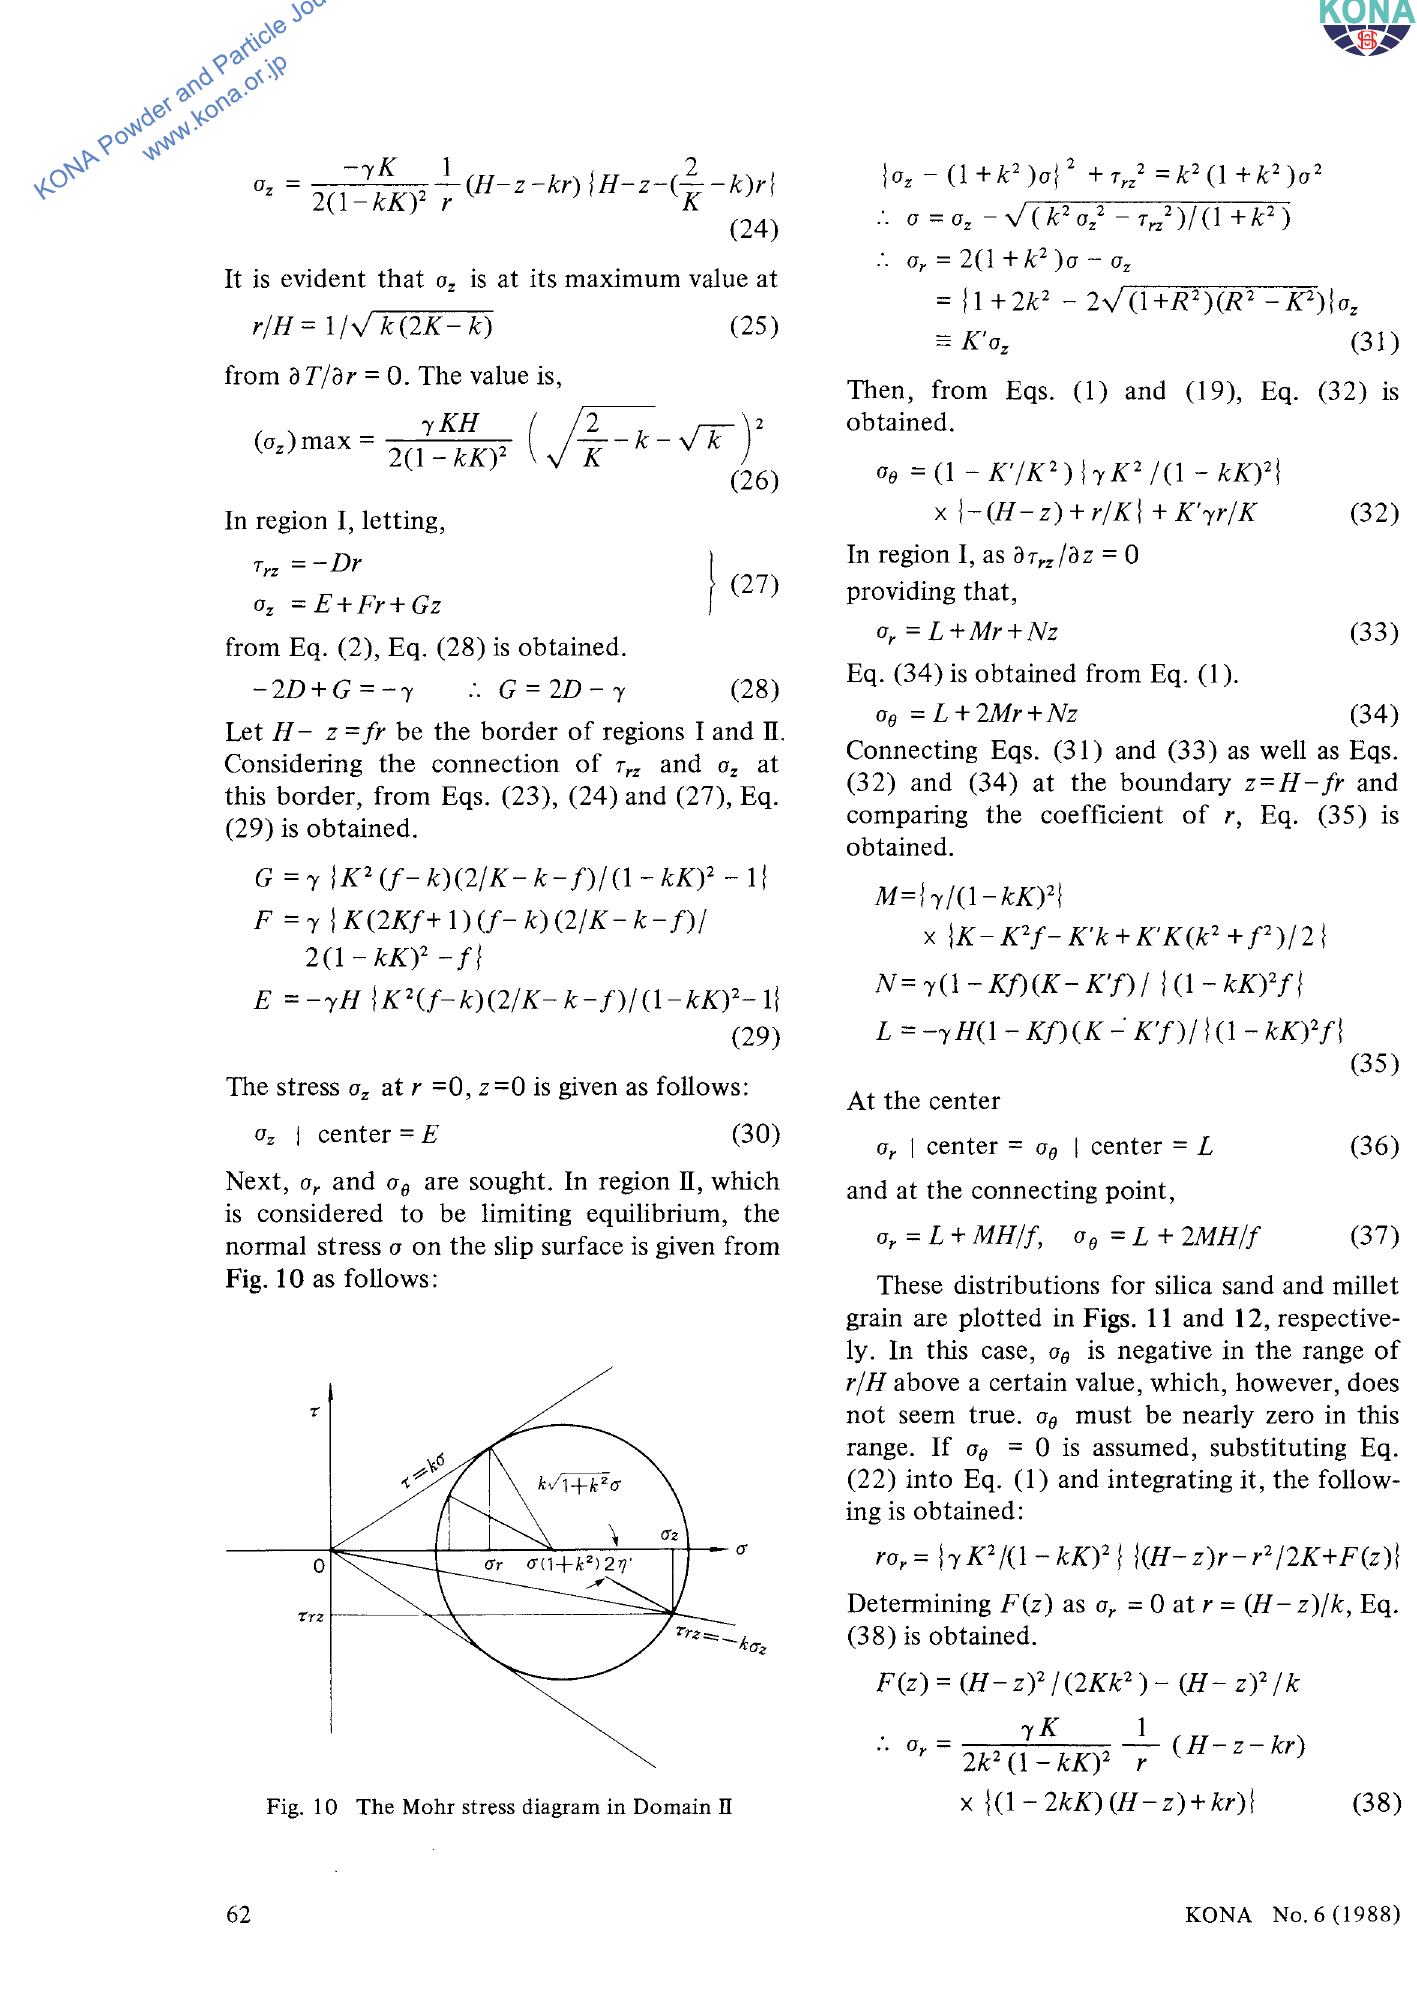
Fig. 1 0 The Mohr stress diagram in Domain